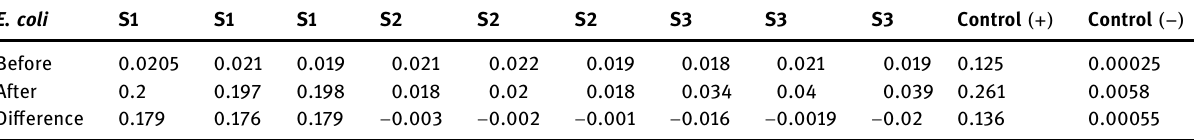
Table 5: Antibacterial inhibitory activity of fi lms against E. coli before and after incubation E.